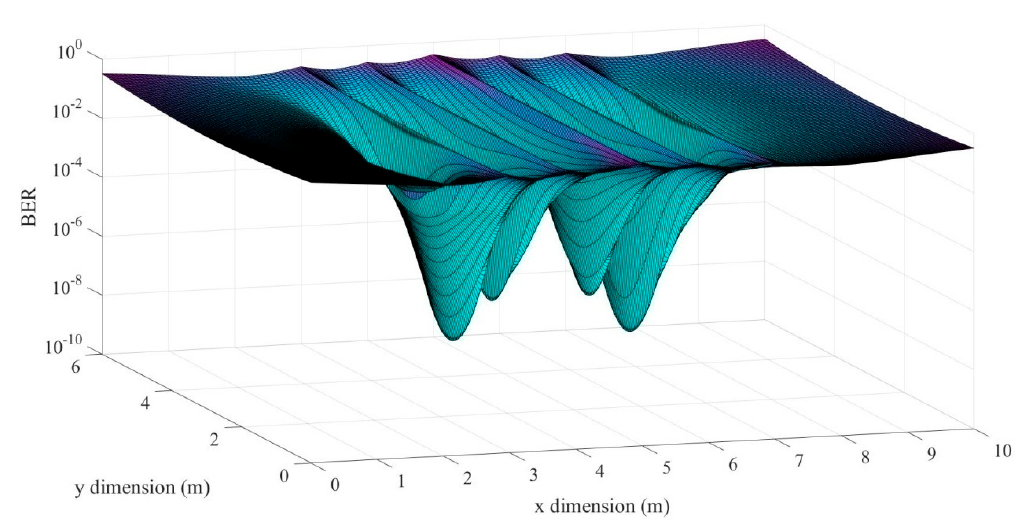
Figure 4. Bit error rate (BER) of the visible light communication (VLC) system under consideration, without the VO 2 optical filter.